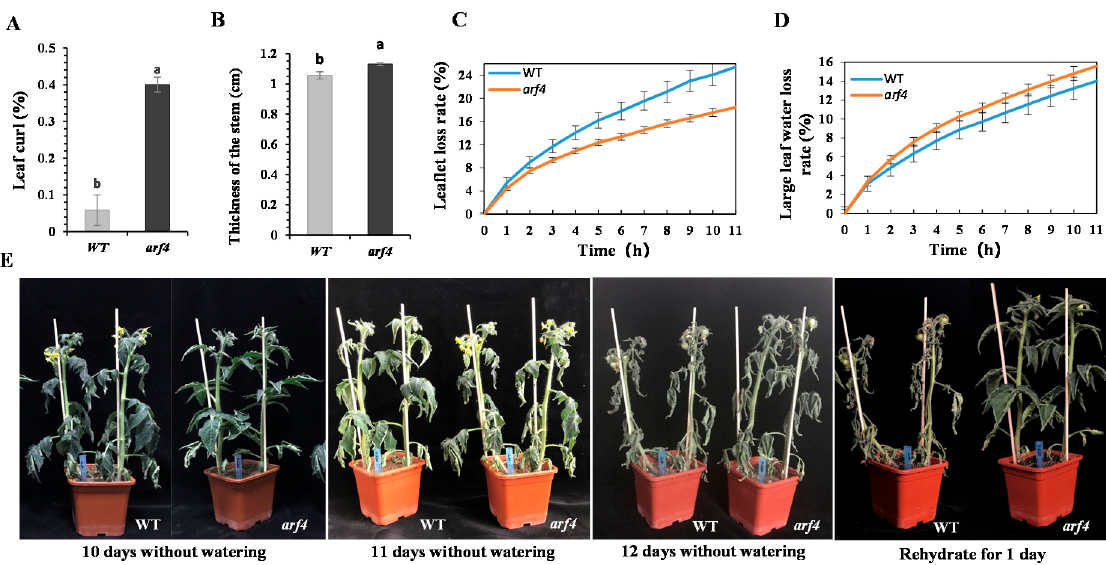
Figure 2. Effects of SlARF4 knockout on resistance to water deficit, morphology, and transpirational water loss in tomato plants. ( A ) Degree of curliness of 2-month-old tomato leaves; ( B ) Thick stem of two-month-old tomato plants. ( C ) Rate of water loss from small leaves isolated from 2-month-old tomato plants at room temperature. ( D ) Rate of water loss from mature leaves excised from 2-month-old tomato plants at room temperature. ( E ) Effect of water deficit on wild-type (WT, left) and arf4 mutant (right) tomato plants. Data was means ± SE of three independent biological replicates. Different letters (a, b) presented significant difference at level set p < 0.05.